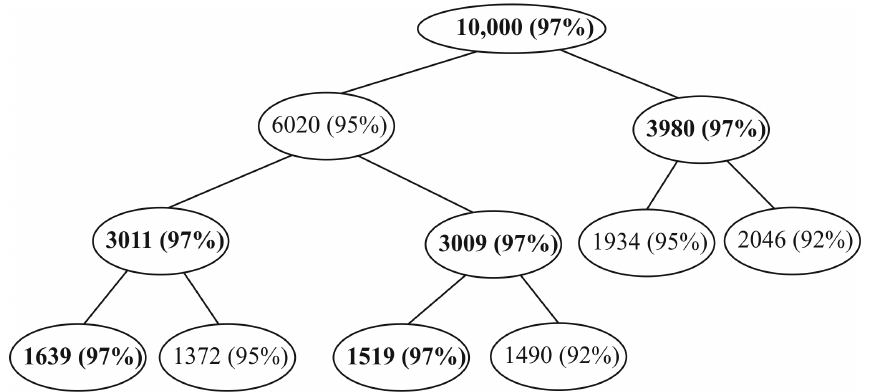
Figure 8. Dendrogram of the GEP distribution into clusters with the classification accuracy of the objects containing as attributes the values of gene expressions of the appropriate